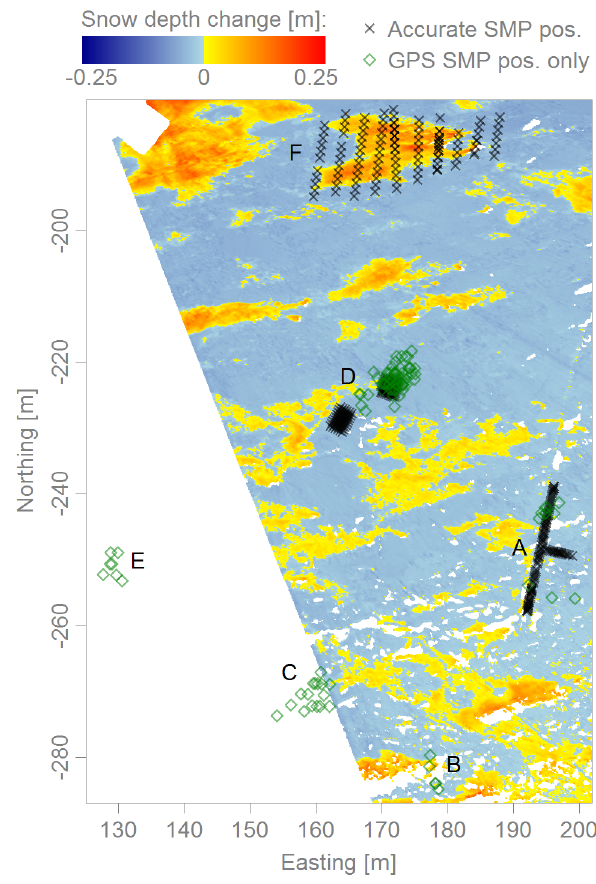
Figure 3. Detail of the area inside the rectangle in Fig. 1 showing all SMP positions. Black crosses show accurately known SMP posi- tions determined with bamboo poles and measuring tape and green diamonds show the less accurately known SMP positions where only the SMP’s internal GPS position is available. The letters are used to mark the different groups of SMP measurements (compare to Fig. 4d). Group A is a T-shaped transect, group D consists of three rectangular grids and group F is 10 transects in the area of one of the newly formed barchan